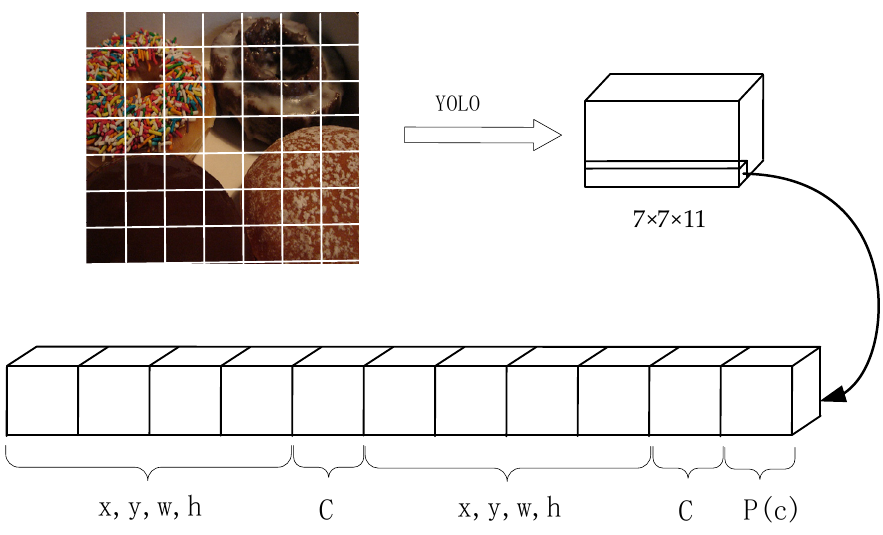
Figure 7. Schematic diagram of YOLO network output structure. Algorithm 1 Data filtering and calculation